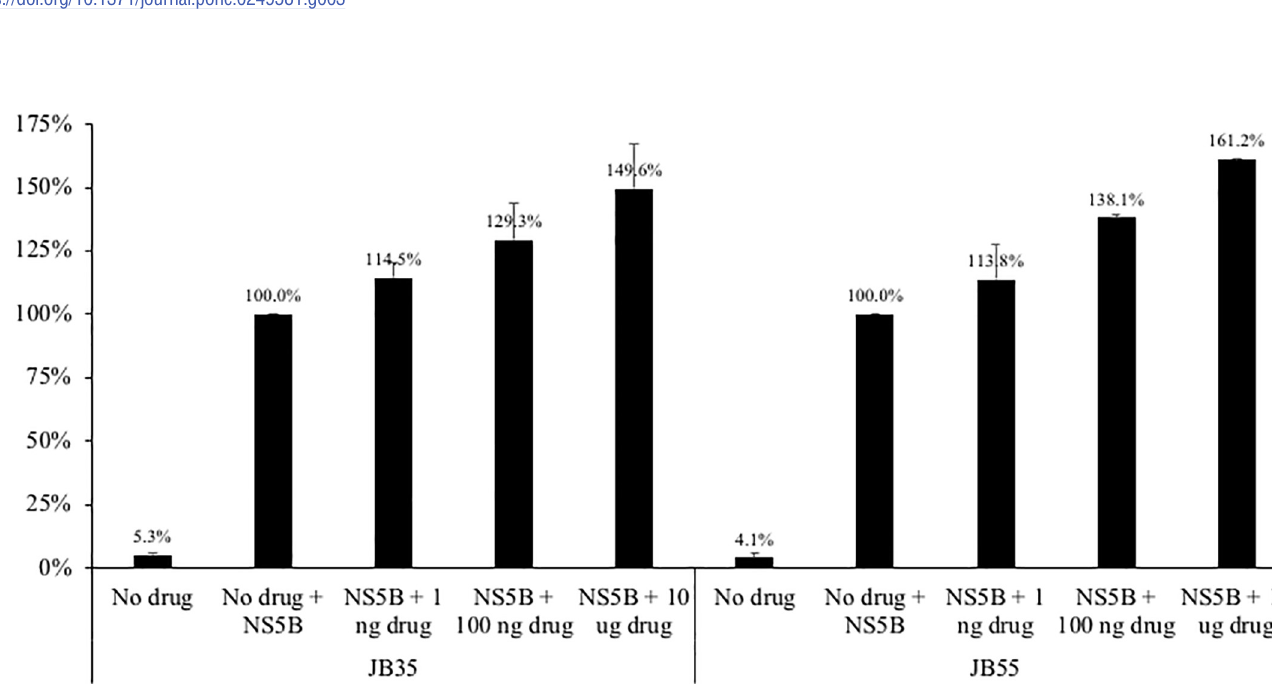
PLOS ONE | https://doi.org/10.1371/journal.pone.0249581 April 14, 2021 7 /